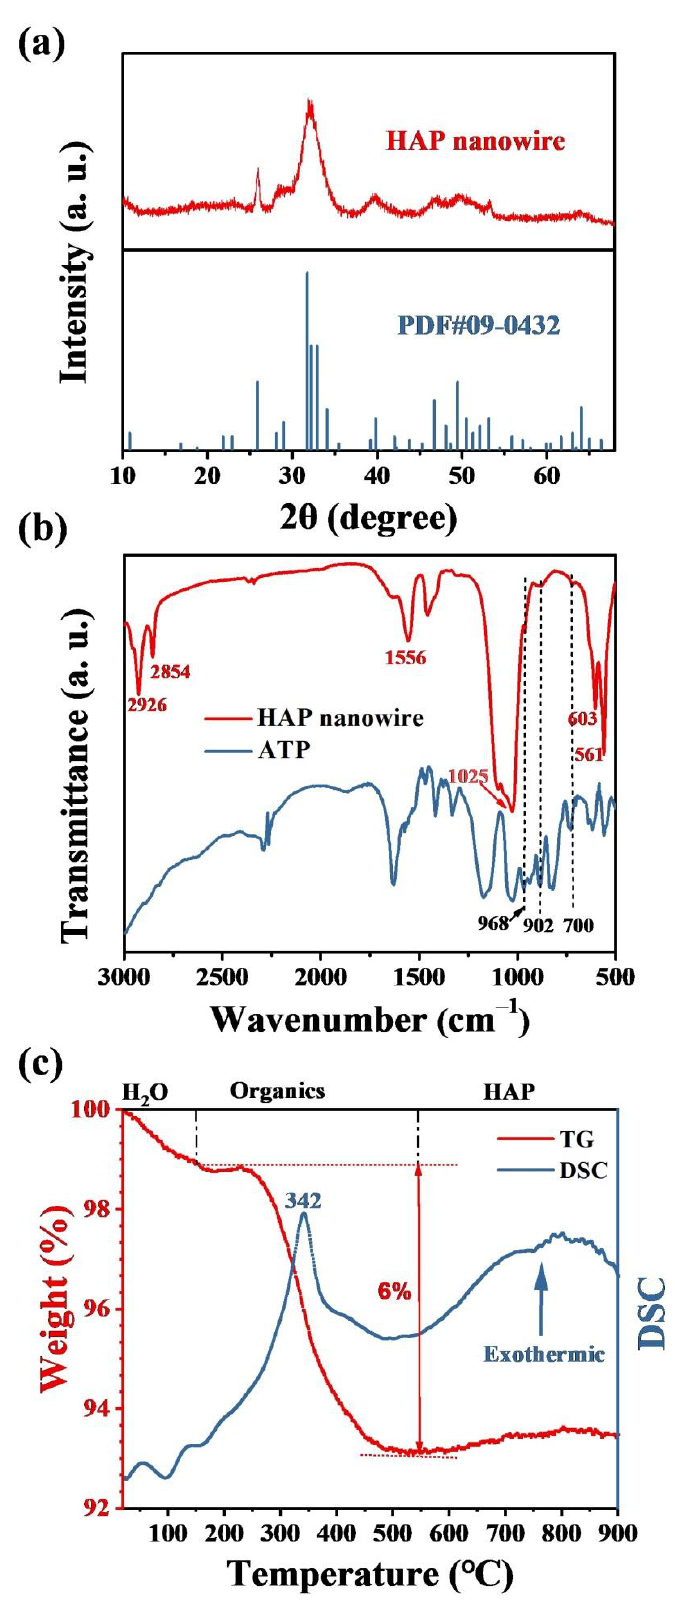
Figure 3. Characterization of ultralong HAP nanowires synthesized by the calcium oleate precursor microwave hydrothermal method using ATP as a bio-phosphorus source in aqueous solution at 180 ◦ C for 60 min. ( a ) XRD pattern. ( b ) FTIR spectra of ultralong HAP nanowires and ATP. ( c ) TG and DSC